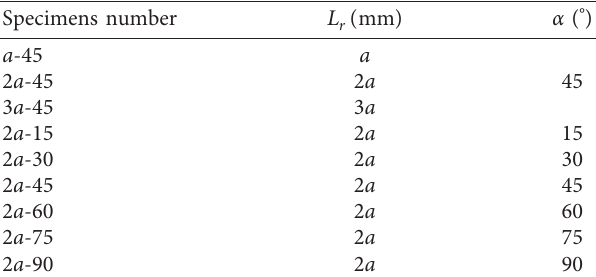
Figure 3: Experimental specimens: (a) models of prefabricated flaws, and (b) rock specimens. Table 1: List of names for models.